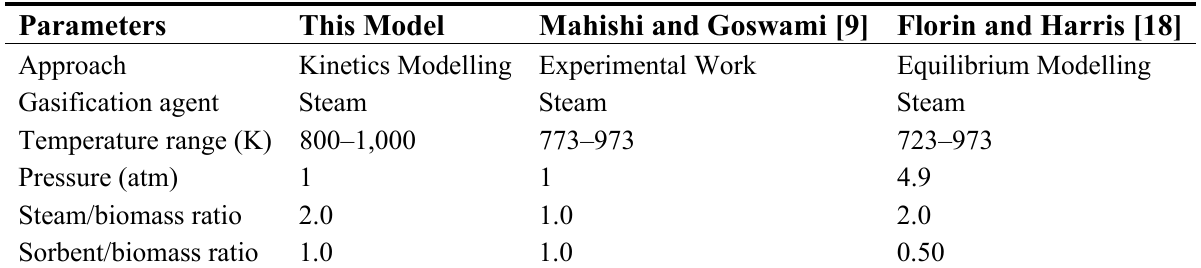
Table 3. Operating conditions for comparison.